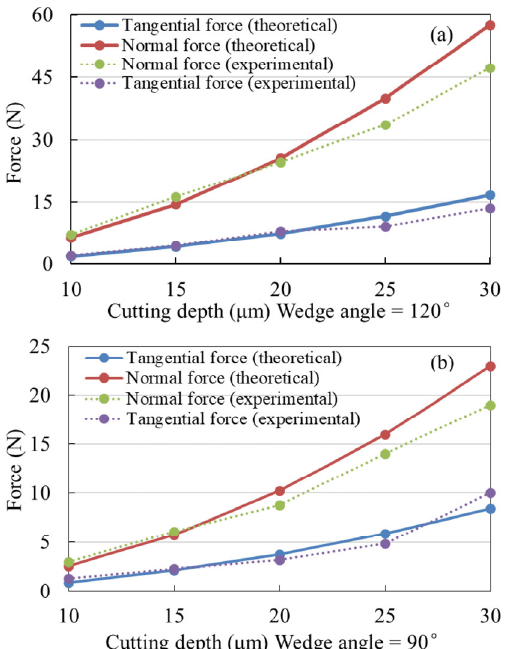
Fig. 9 Grinding force for wedge angles of (a) 120° and (b) 90°.